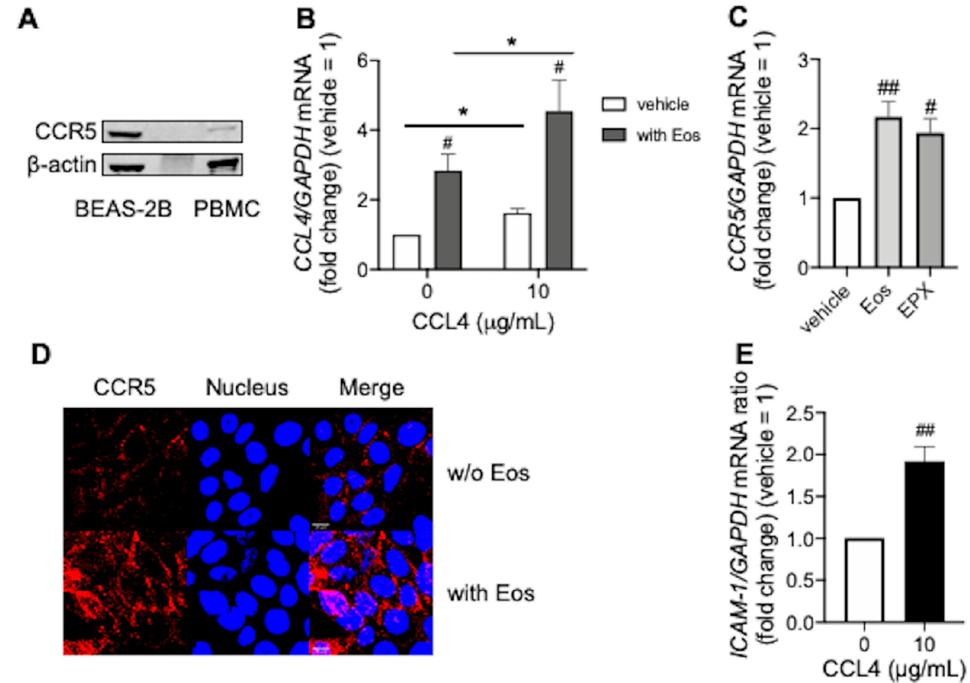
Figure 3. Autocrine effects of CCL4 during eosinophilic inflammation. ( A ) CCR5 expression in BEAS-2B cells. Peripheral blood mononuclear cells (PBMC) were used as a positive control. Experiments were repeated at least three times with different cell preparations. ( B ) CCL4 mRNA levels in BEAS-2B cells co-incubated overnight with CCL4 and/or purified peripheral blood eosinophils. ( C ) CCR5 mRNA levels in BEAS-2B cells co-incubated overnight with purified peripheral blood eosinophils, or EPX (10 µg/mL) for 48 h. ( D ) CCR5 expression in BEAS-2B cells co-incubated overnight with purified peripheral blood eosinophils. CCR5 (red) and the nucleus (blue) are shown in upper (without eosinophils) and in lower (with eosinophils) panels, respectively. Images were obtained using a FV3000 confocal microscope (400× objective). Scale bars in the bottom-left corner of Merge indicate 10 µm. Results were representative of at least three experiments. Values in ( B , C , E ) represent the mean ± standard error of the mean from four experiments; # p < 0.05, ## p < 0.01 (vs. vehicle in each group), * p < 0.05 (as shown between the two groups).